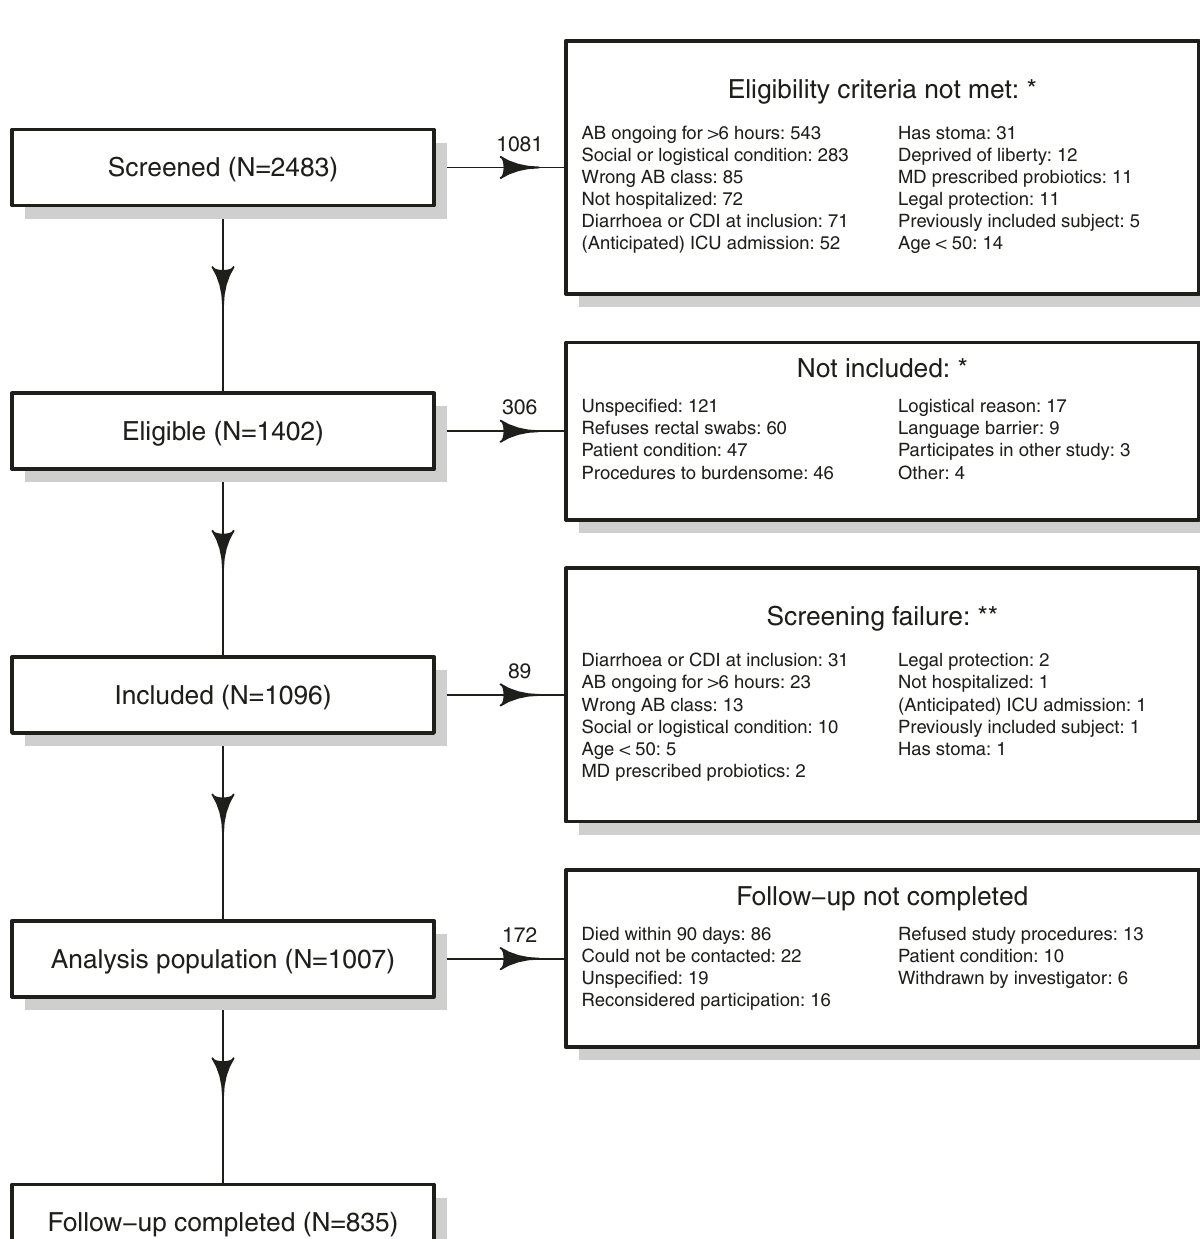
Fig. 1 Inclusion fl owchart. *Based on 28 hospitals that provided screening data. Hospitals were requested to complete on the screening log for all screened patients up to March 23, 2017, and all eligible patients for the entire study period. Of the enrolled patients, 897 (89.1%) were enrolled in hospitals that provided screening data. **Subjects who signed informed consent but met one of the exclusion criteria at baseline. This includes 33 subjects from one side that applied an early consent procedure for subjects at high risk of receiving antibiotics in the near future. Abbreviations : AB antibiotics, CDI C. dif fi cile infection, ICU intensive care unit, MD medical the RR observed in the validation dataset: RR 4.6 (95% CI: 1.4 – 28.8) for the ratio of OTU1/OTU31 and RR 6.2 (95% CI: 2.0 – 34.8) for the relative abundance of OTU1 ≥ 0.087% and OTU68 < 0.087% (Supplementary Tables 5 and 6). Most but not all of the alternative OTU models were con fi rmed in the validation. For CDI within 28 days, predictive performance of 16S rRNA gene sequencing data could not be estimated due to the low number of CDI episodes within 28 days.